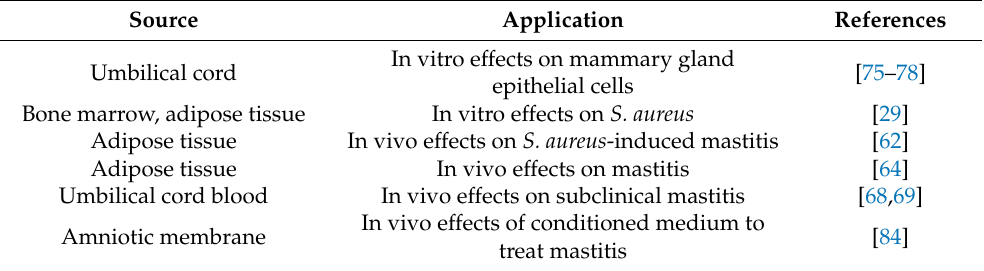
Table 2. Bovine MSC applications for the mammary